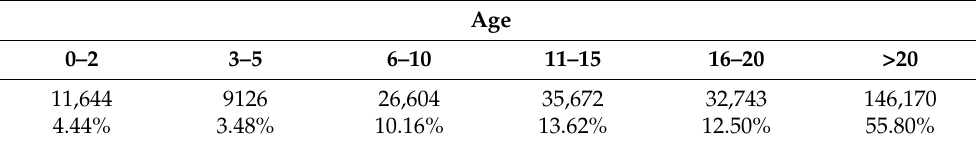
Table 3. Total number of tractors registered in the period 2012–2019, by age